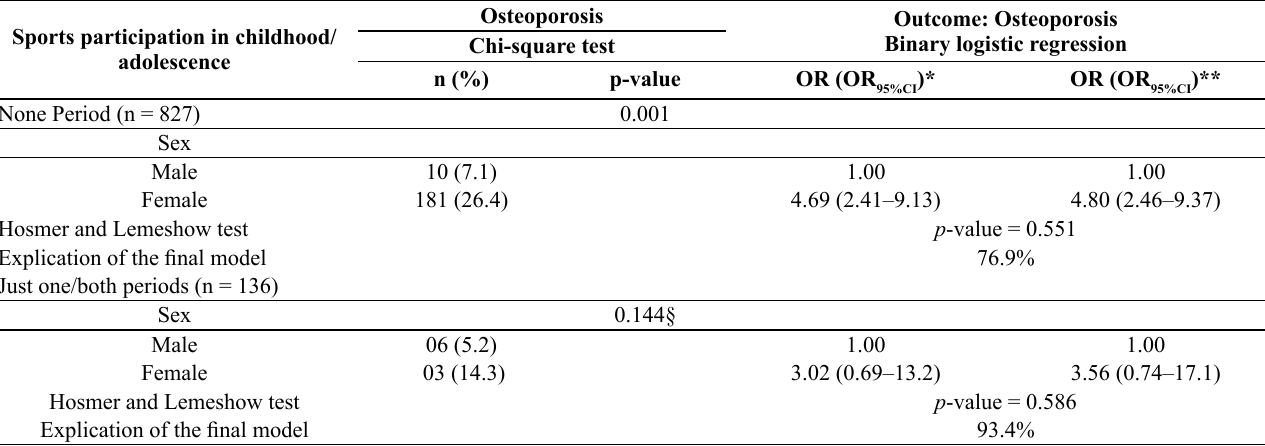
Osteoporosis Outcome: